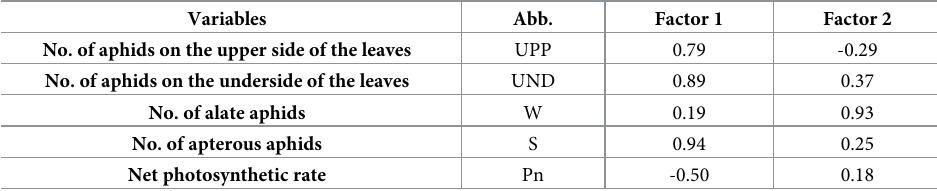
Table 2. The factor loadings determined for five measured variables of factor 1 and factor